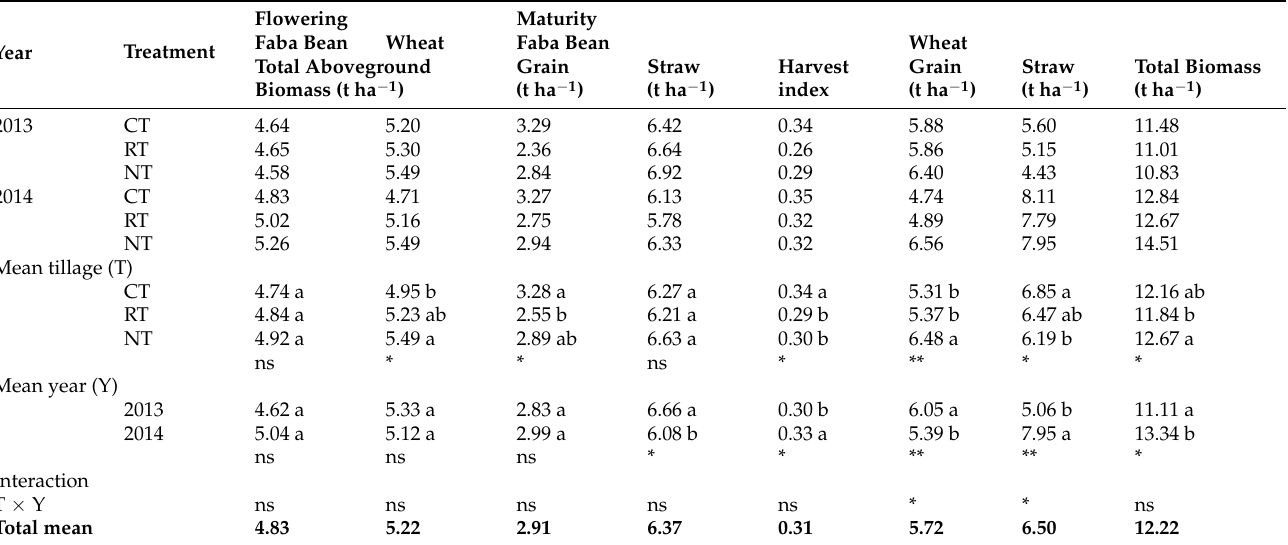
Table 2. Faba bean and wheat aboveground biomass at flowering and straw (stem and leaves) and grain yield at maturity with respect to year and tillage